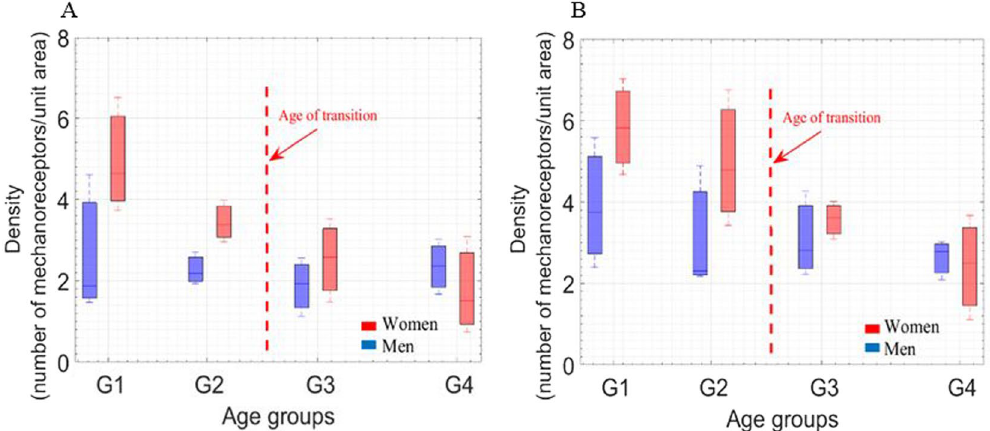
old), respectively, for men and women. Pearson’s statistical analyses: ( + for r > 0.8, − for r < − 0.8)